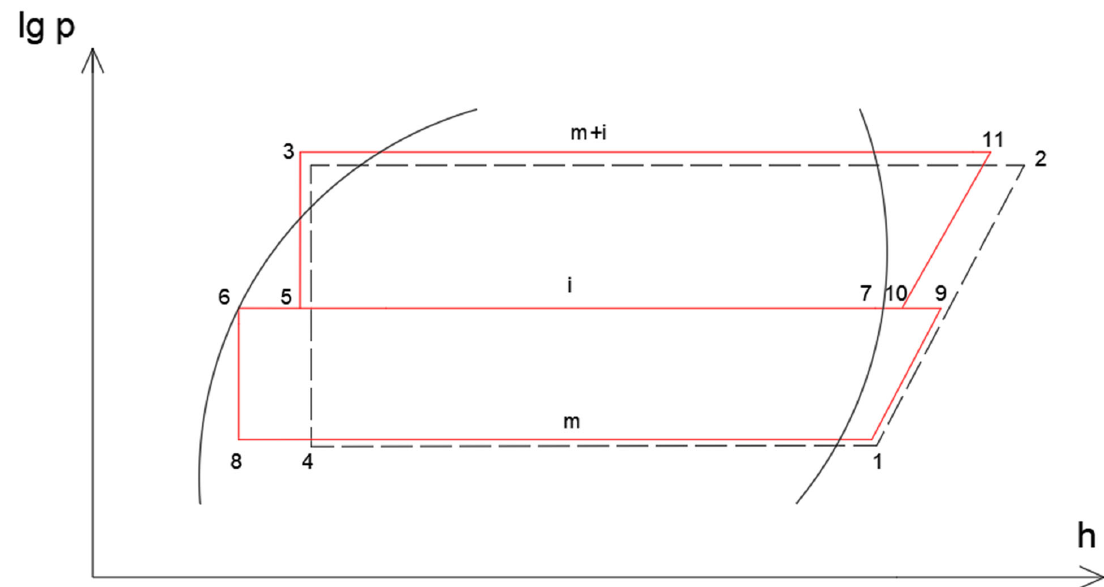
Figure 5. Diagram of the pressure enthalpy of the system.